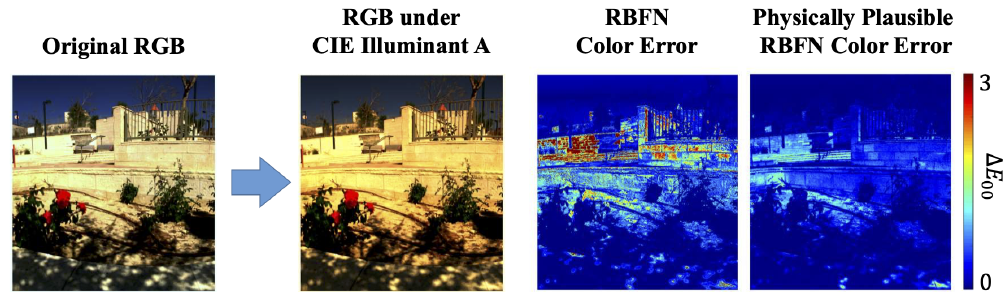
Figure 4. The scene relighting color fidelity of one example hyperspectral image recovered by the RBFN algorithm [36] and by our physically plausible modification of RBFN. The results are shown as the error maps of CIE ∆ E 2000 color differences ( ∆ E 00 )